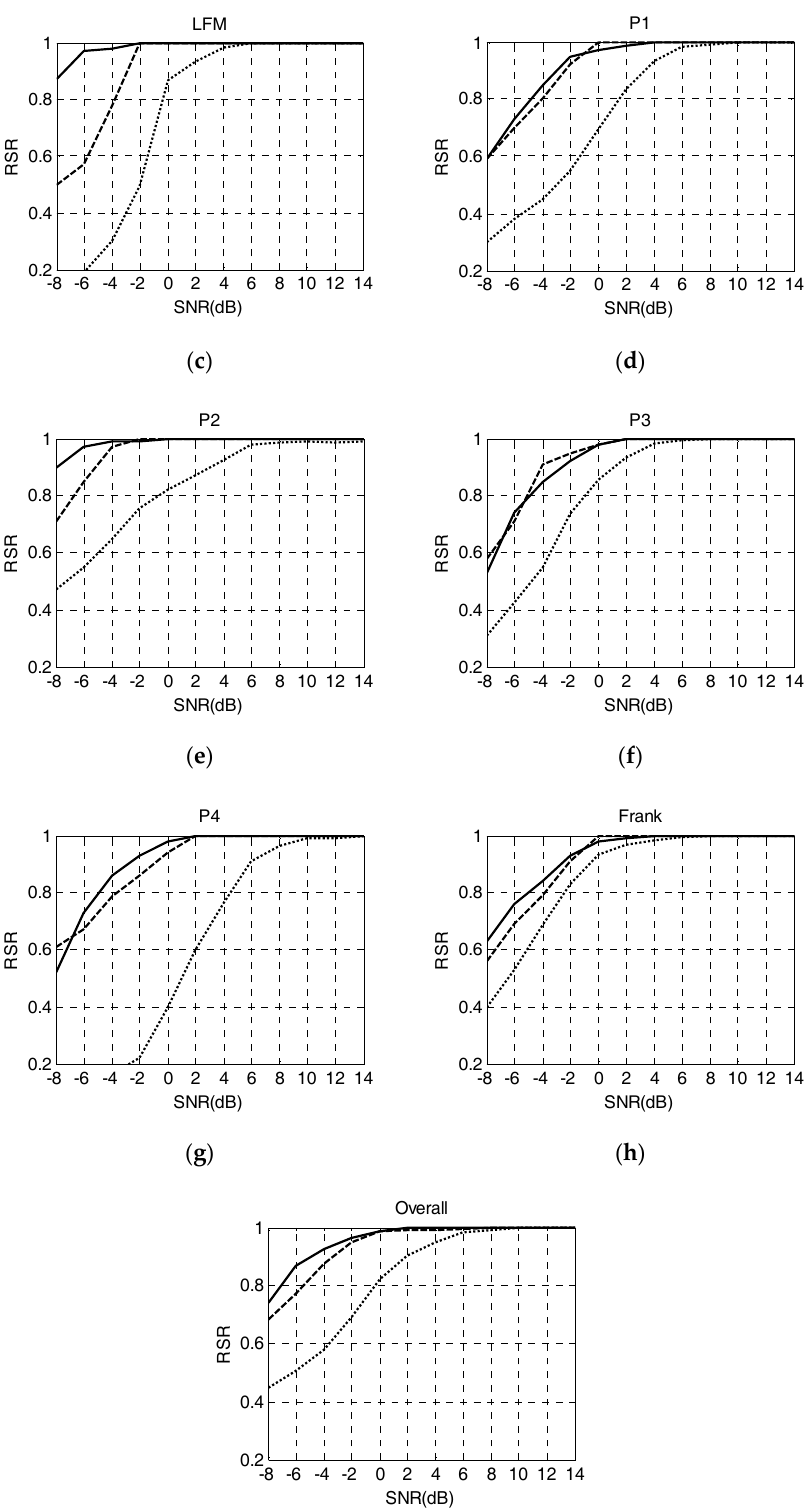
Figure 10. Recognition accuracy at different SNR of each waveform. The overall RSR is 92% at SNR of − 4 dB for this paper. ( a ) The RSR of BPSK ( b ) The RSR of Costas, ( c ) The RSR of LFM, ( d ) The RSR of P1, ( e ) The RSR of P2, ( f ) The RSR of P3, ( g ) The RSR of P4, ( h ) The RSR of Frank, ( i ) The overall RSR. When SNR is − 4 dB, the overall RSR of this paper is 92%, the RSR of Costas and BPSK is 100% and the RSR of LFM and P2 is above 95%. The CWD images of P1, P3, P4 and Frank are similar, especially in low SNR conditions. Therefore, the effects of them are not excellent and the RSR is about 85%. What’s more, the untrained waveforms T4 code [26] with the number of phase states of 2 is used to test the performance of system. After calculation, the probability that T4 is divided into unclassified waveforms is 89%. The specific results of this paper at SNR = − 4 dB are displayed in Table 5. Table 5. Classification results of this paper at SNR = − 4 dB. BPSK